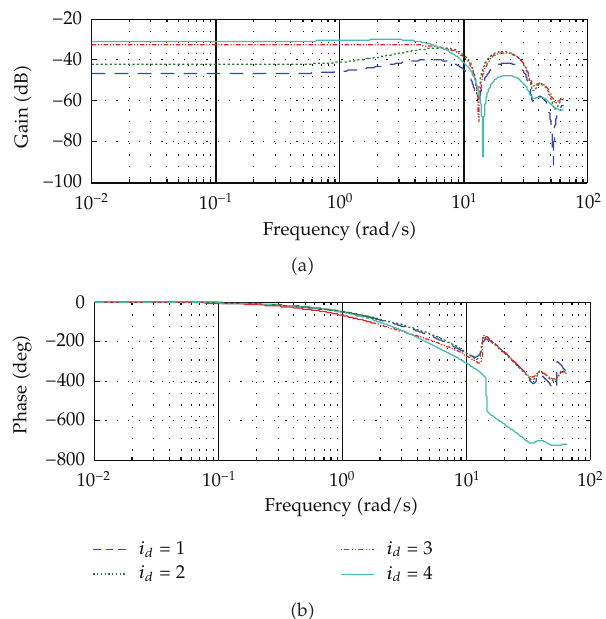
(cid:4) z (cid:5) ’s (cid:4) n (cid:7) 8 (cid:5) . ARX